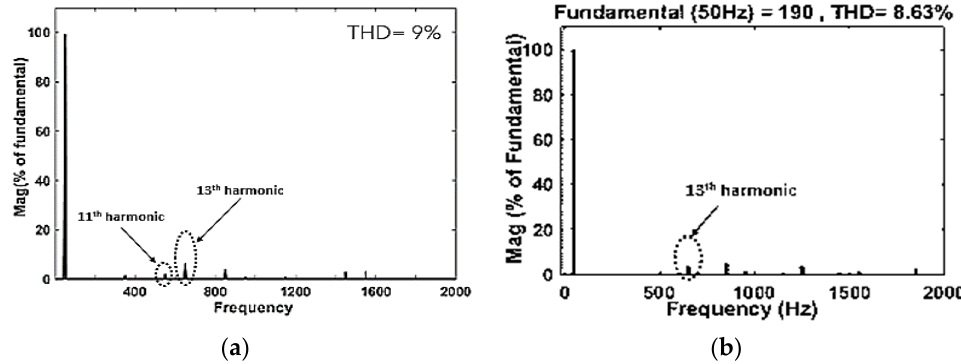
Figure 14. ( a ) Experimental THD of output voltage; ( b ) Simulated THD of output voltage.